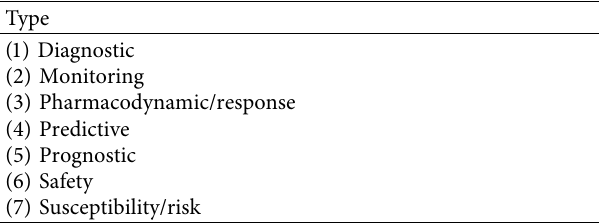
Table 1: Biomarker